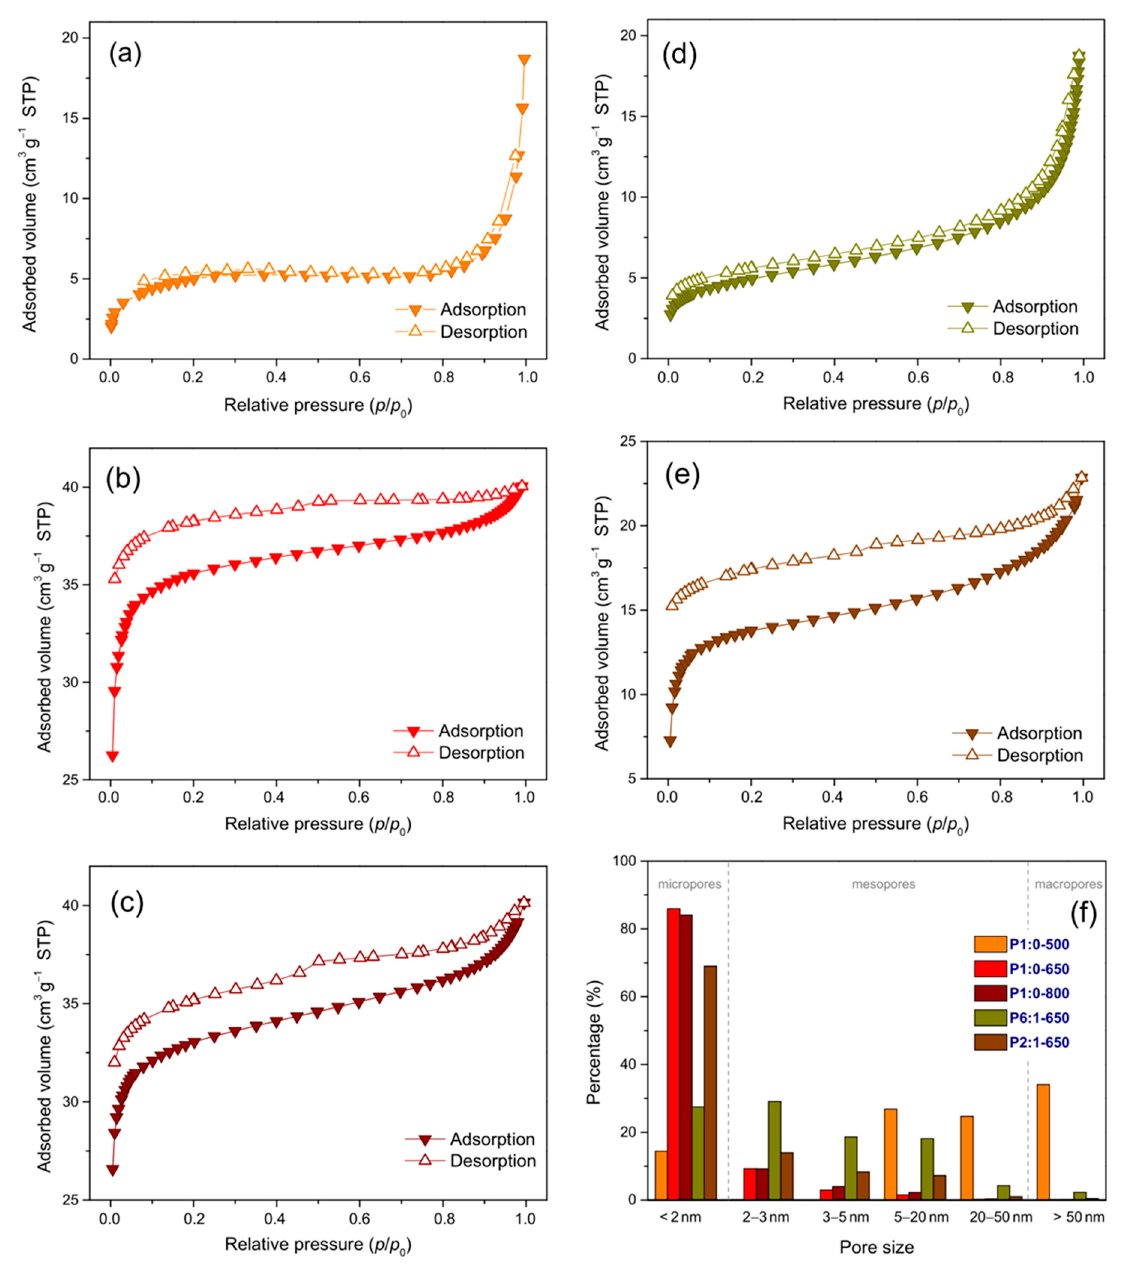
Figure 3. Nitrogen sorption isotherms of membranes ( a ) P1:0-500, ( b ) P1:0-650, ( c ) P1:0-800, ( d ) P6:1-650 and ( e ) P2:1-650, and ( f ) pore size